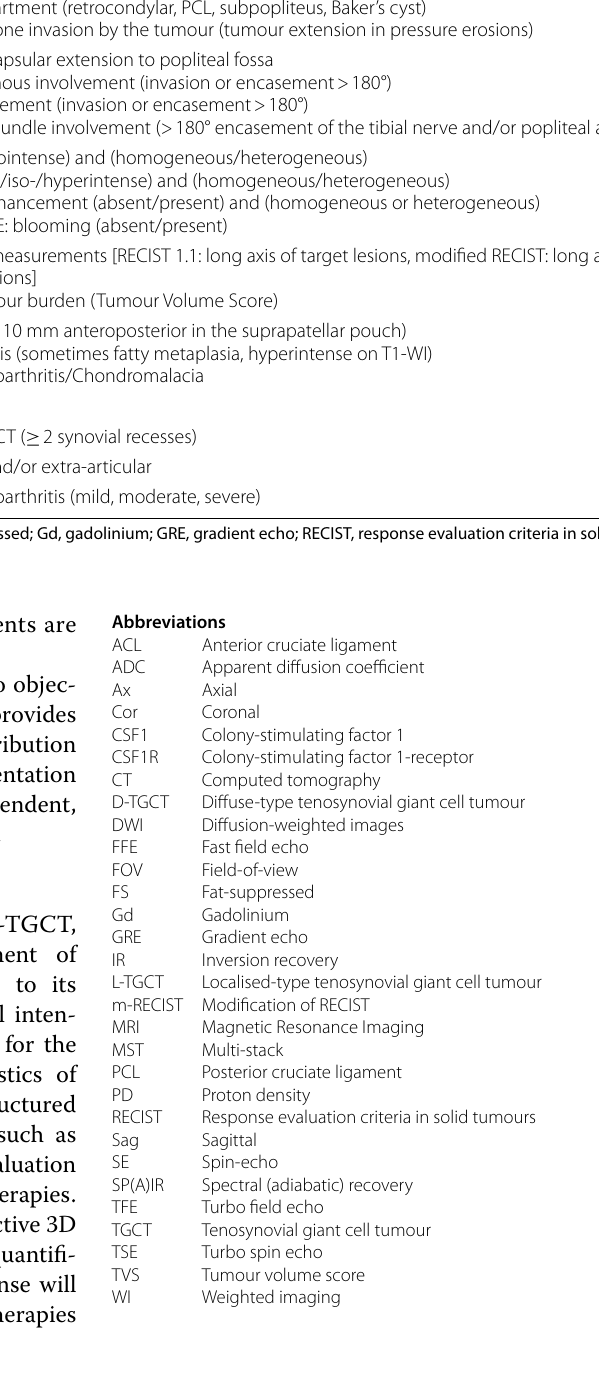
PCL, posterior cruciate ligament; WI, weighted imaging; FS, fat-suppressed; Gd, gadolinium; GRE, gradient echo; RECIST, response evaluation criteria in solid tumours